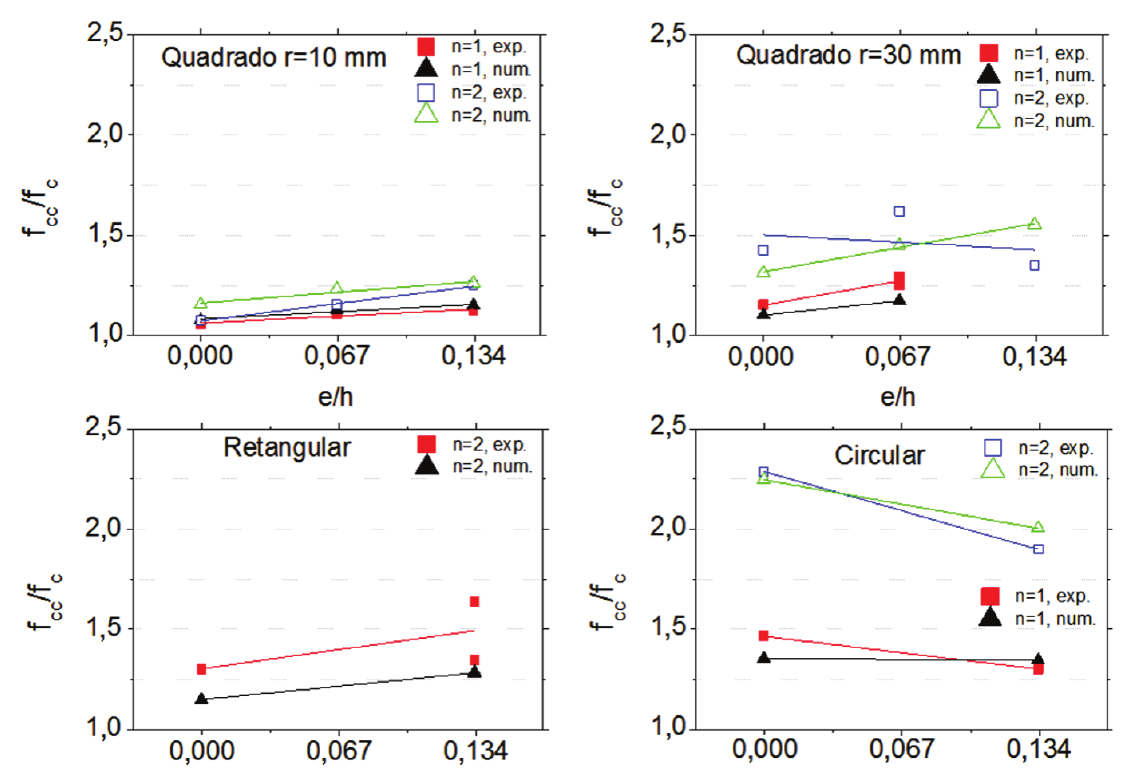
Figura 15 Influência da excentricidade relativa no acréscimo de tensão axial nos pilares das séries de 1 a